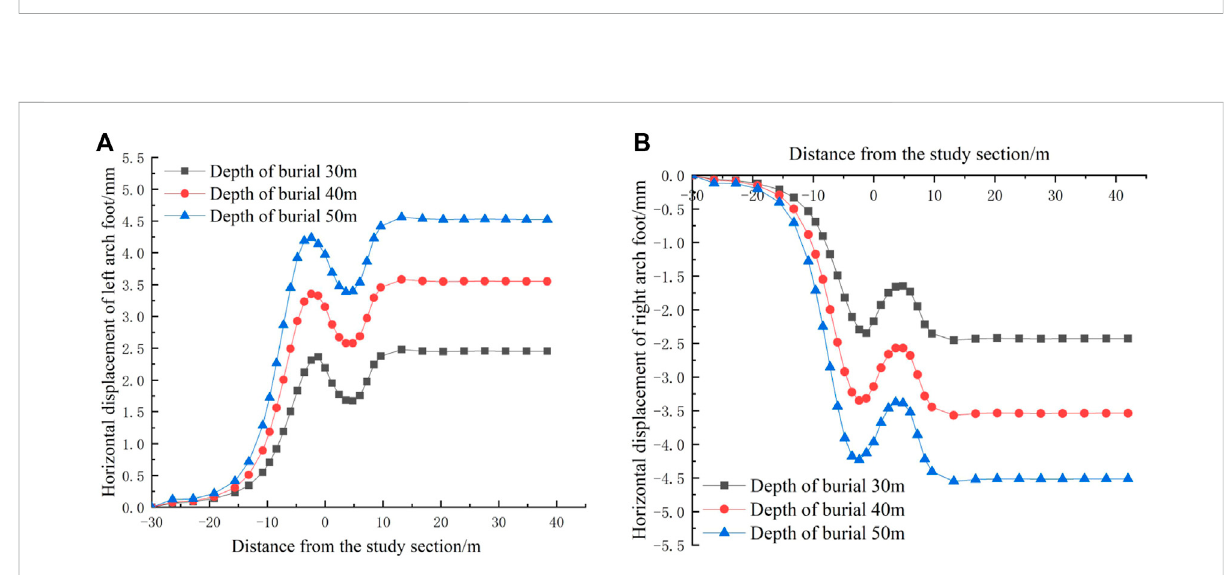
FIGURE 12 Horizontal displacement curveofanarchwaist. (A) Horizontal displacement curveofthetunnelleftarchwaist;and (B) horizontaldisplacement curve of the tunnel right arch